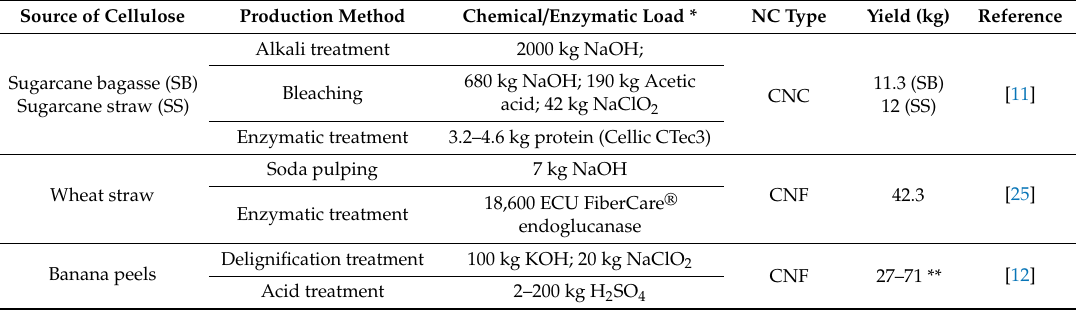
Table 1. Nanocellulose production, method of production, and yield obtained per 100 kg of raw material. Source of